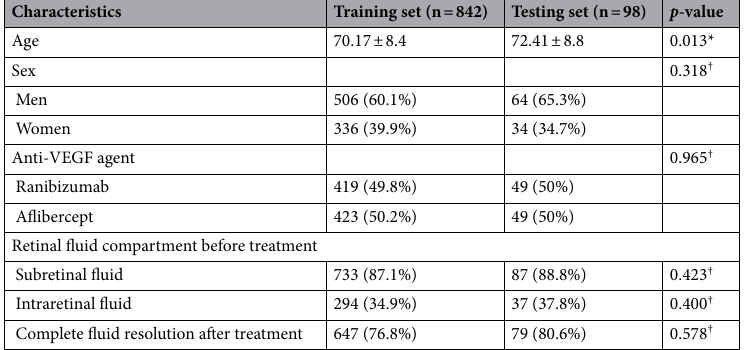
Table 1. Characteristics of patients included in the training and testing sets. Data are presented as mean ± standard deviation or percentage (%), where applicable. VEGF, vascular endothelial growth factor. *Independent sample t-test. † Chi-square test.